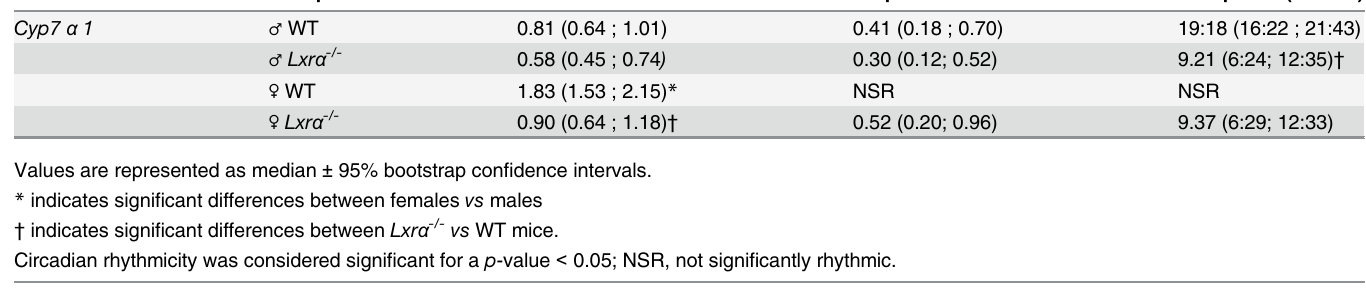
Table 3. Cosinor analysis of Cyp7 α 1 circadian expression in WT and Lxr α -/- mice. Gene